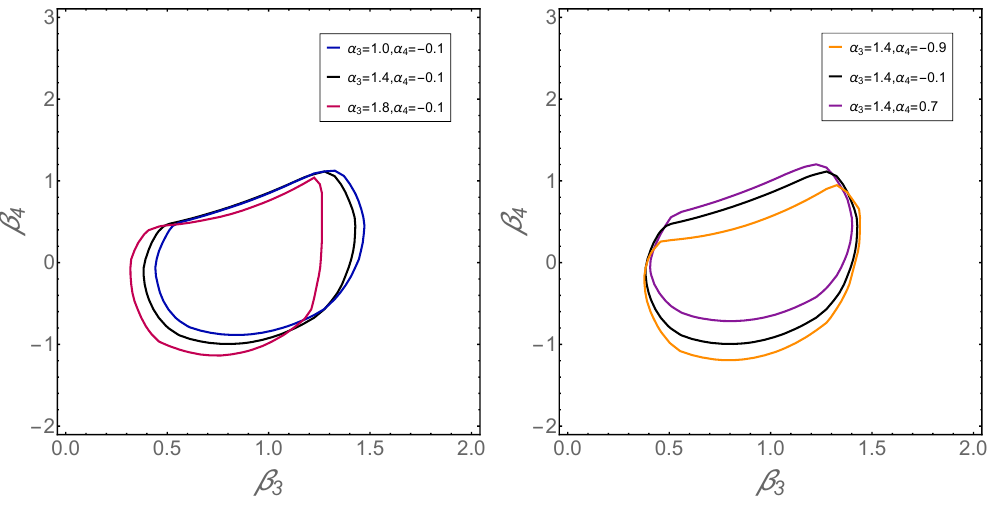
Figure 11 . (Line theory) Positive regions in the ( β 3 , β 4 )-plane (the regions within the solid lines are allowed by the generalized elastic positivity bounds). We choose ˜ x = 1 and γ = 1 (or equiva- lently θ = 0 . 4